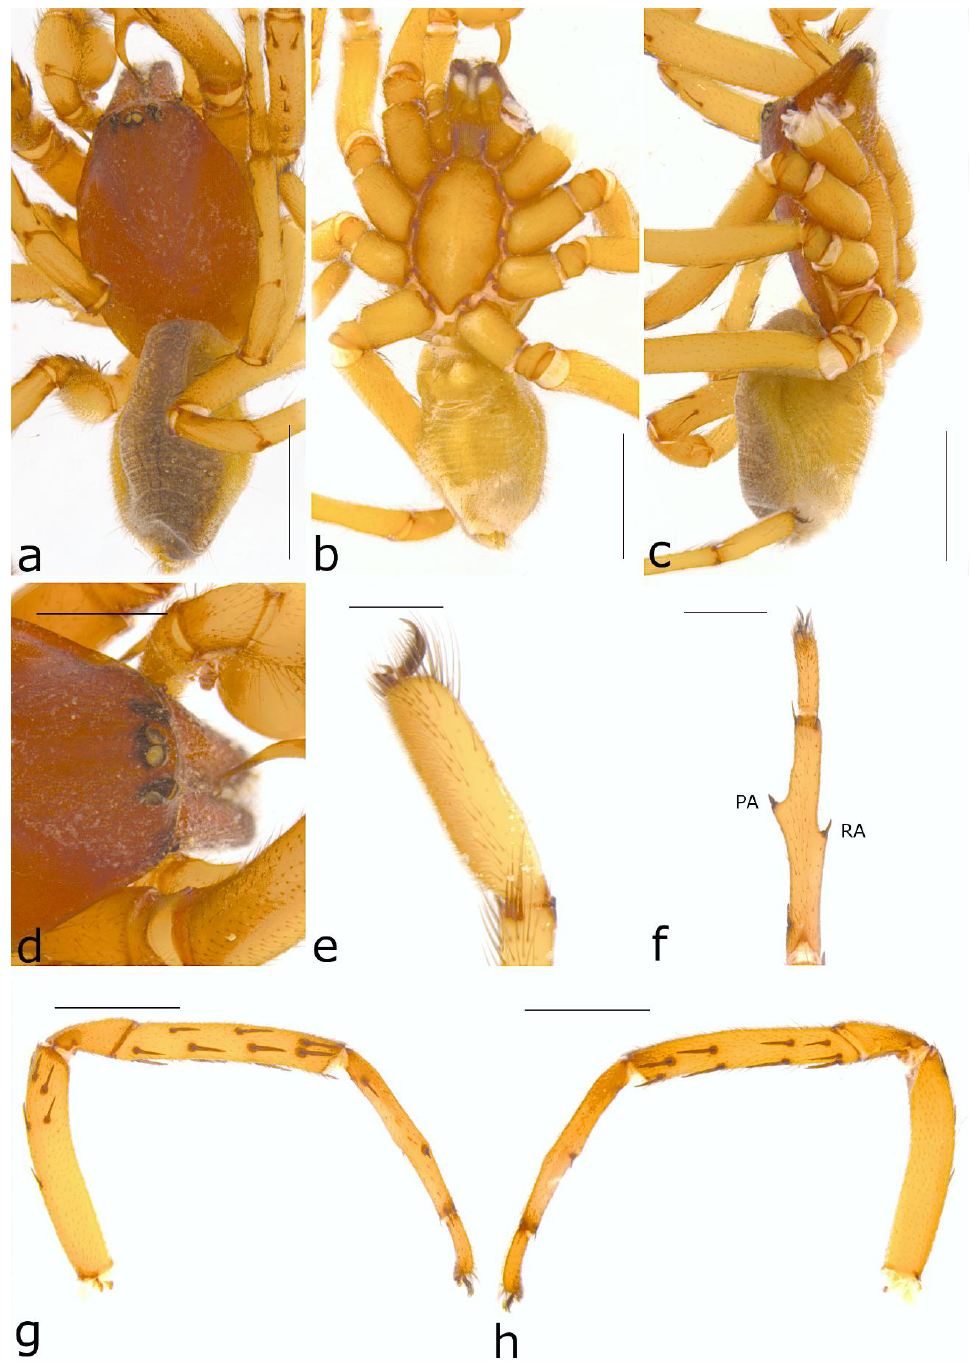
Figure 35. Ariadna diucrura sp. nov. ♂ holotype (SAMA NN31206) from Roxby Downs (SA): ( a ) habitus, dorsal view; ( b ) same, ventral view; ( c ) same, lateral view; ( d ) eyes, dorsal view; ( e ) left metatarsus IV, preening comb, retrolateral view; ( f ) left leg I, ventral view; ( g ) same, prolateral view; ( h ) same, retrolateral view. Scale bars ( a – c ) = 2 mm, ( d ) = 1 mm, ( e ) = 0.5 mm, ( f ) = 1 mm and ( g , h ) = 2 mm.